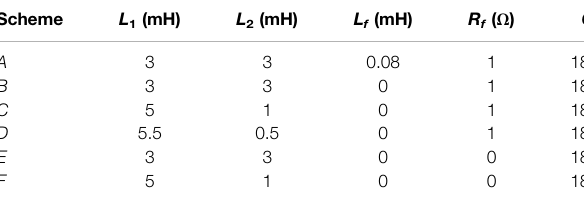
TABLE 3 | Comparison of systerm